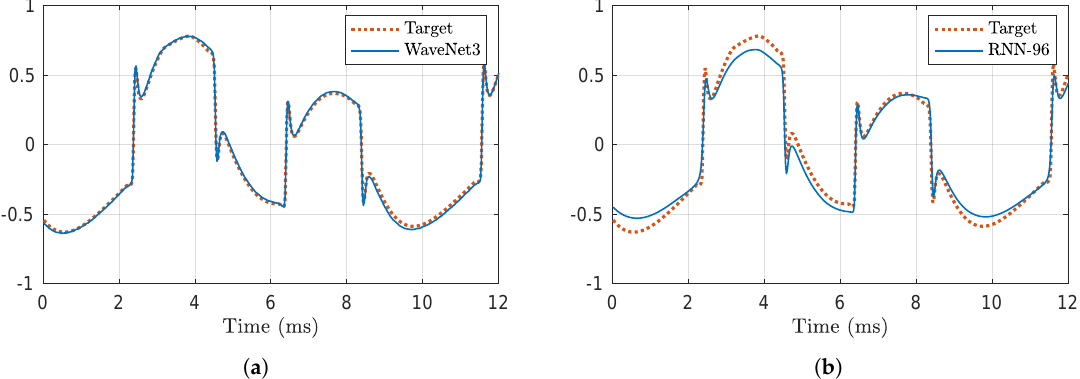
Figure 15. Waveforms of amplifier and neural network model outputs. ( a ) Waveform of a guitar sound processed through the HT5M amplifier, and the WaveNet3.; ( b ) Waveform of a guitar sound processed through the HT5M amplifier, and the